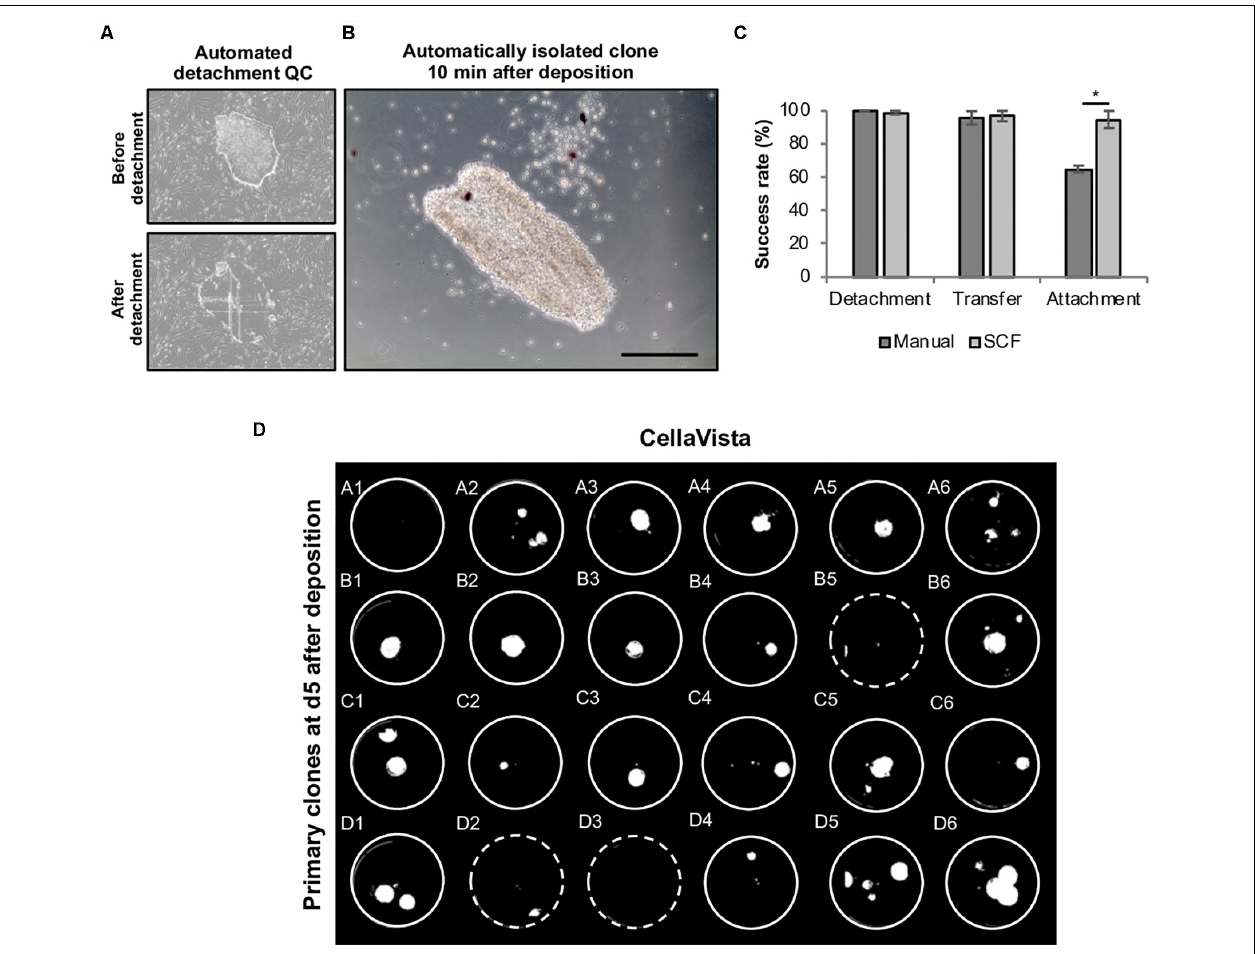
FIGURE 6 | Automated harvesting of primary hiPSC clones using the CellCelector system. Primary colonies were automatically detached and clonally deposited in a 24-well plate. (A) Representative images (automatically taken by the CellCelector as a quality control parameter) of primary hiPSC clones before and after automated detachment. (B) Representative image of a primary hiPSC clone 10 min after automated clonal deposition. (C) Comparative analysis of detachment, transfer and attachment efficiency in manual versus automated processing. Shown are mean values ± SD, n = 48 (manual), n = 96 (SCF). (D) Whole 24-well plate detection of primary clones at day 5 after clonal deposition. Dashed wells contain clones located close to the wall of the wells are thus difficult to visualize. Scale bar: 100 µ m. SCF, StemCellFactory. * p ≤ 0.005 (Unpaired Students T